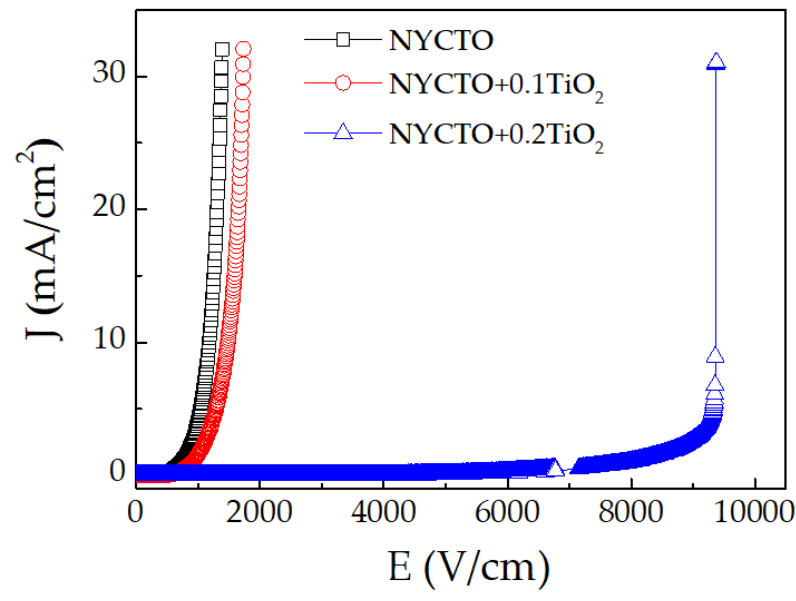
Figure 8. Nonlinear current density ( J ) — Electric field ( E ) at room temperature for NYCTO + xTiO 2 ceramics with x = 0.0, 0.1 and 0.2.